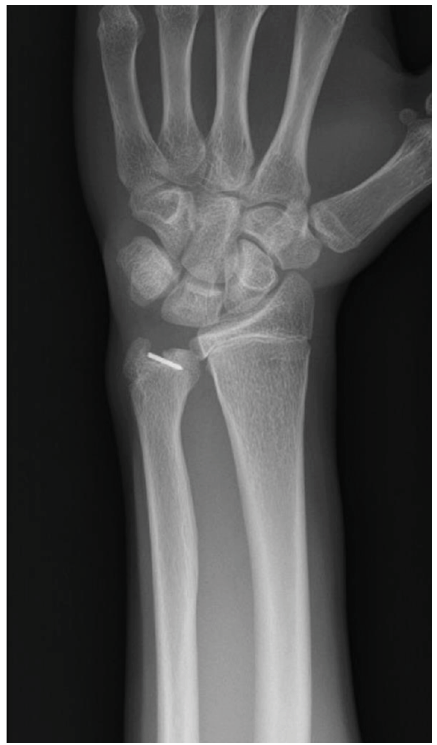
Figure 5: Anterioposterior and lateral X-ray 1 year after surgery shows premature physeal closure and mild negative ulnar